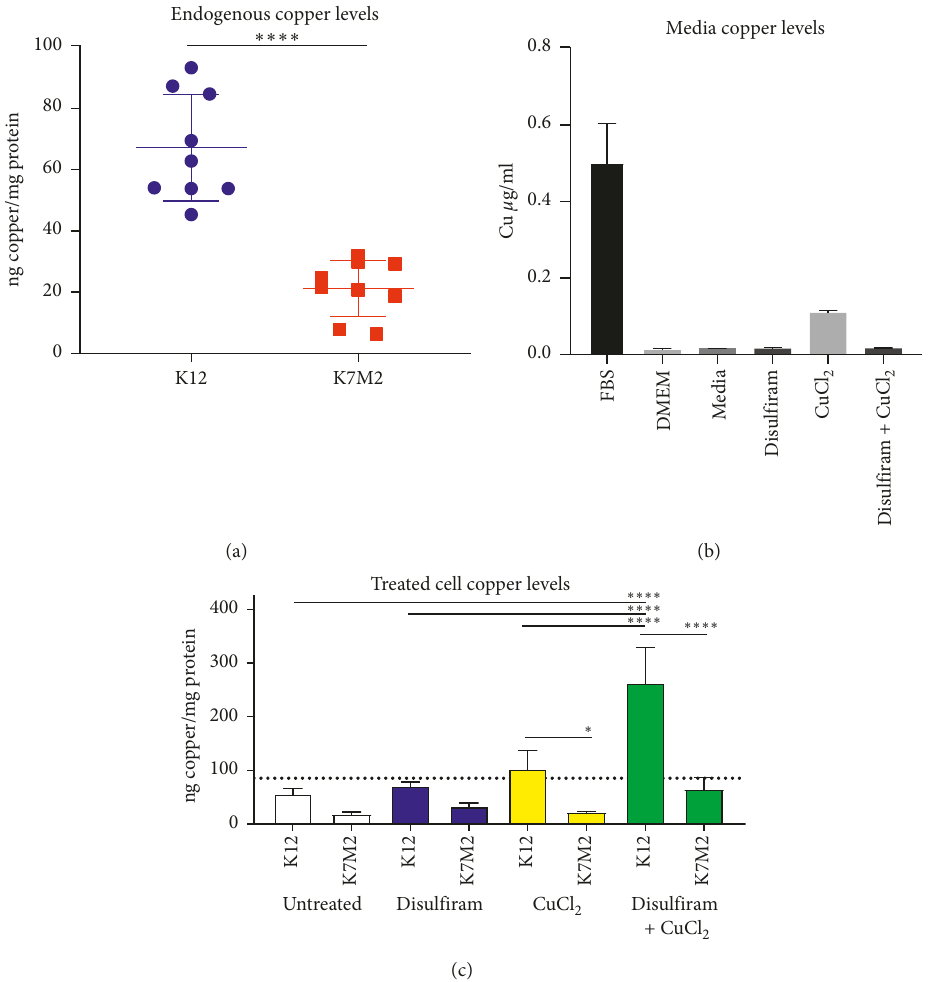
Figure 1: Murine OS cell line K12 displays higher levels of intracellular Cu compared to K7M2. Clonally related OS cell lines (K12 and K7M2) were cultured under identical conditions and then collected for protein quantification and intracellular Cu analysis using atomic absorption (AA) spectrophotometry. (a) Low metastatic K12 cells displayed significantly higher intracellular Cu levels than K7M2 ( n � 6 ) . (b) AA analysis of media components and media containing Dis (3 μ M), CuCl 2 (1 μ M), and Dis+CuCl 2 (0.1 and 0.25 μ M, respectively) was performed ( n � 3 ) . (c) Both K12 and K7M2 cells were cultured or media treated with Dis, CuCl 2 , or Dis+CuCl 2 at doses previously AA tested ( n � 3 ) . Copper analysis was performed using three independently cultured and processed samples. ∗ p < 0 . 05; ∗∗∗∗ p < 0 .